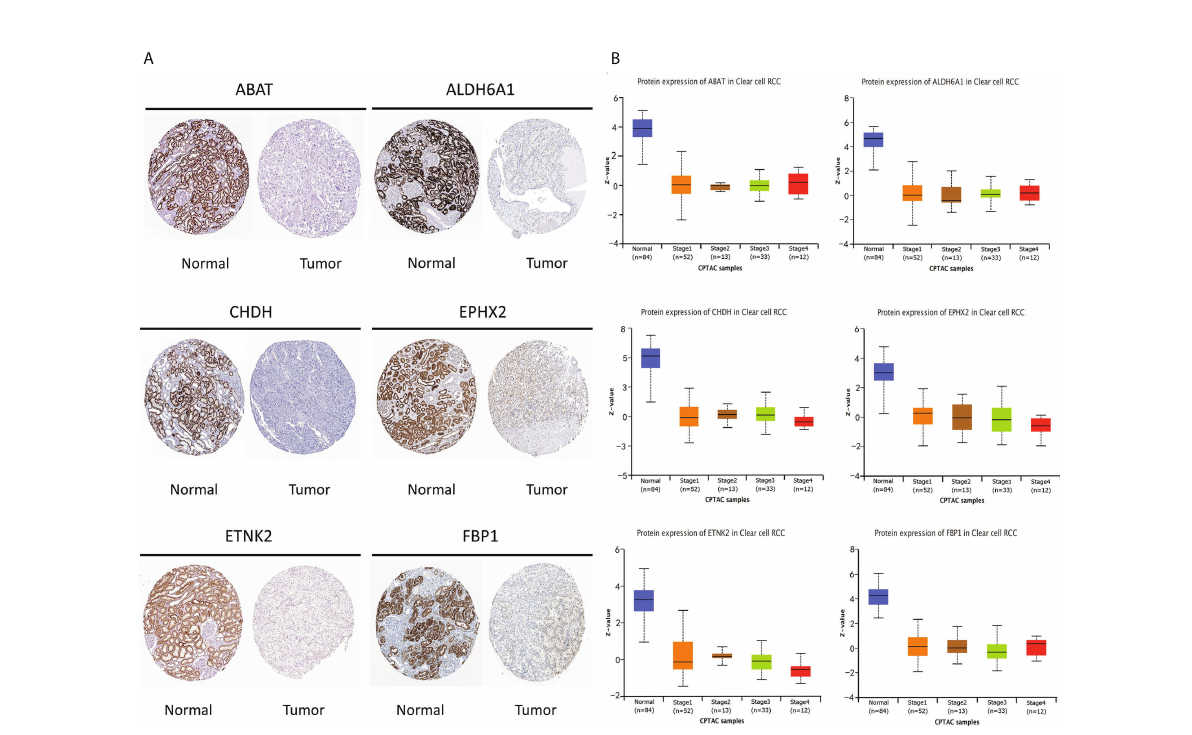
FIGURE 5 The protein level of the six key genes in kidney normal tissues and ccRCC tissues. (A) Immunohistochemical of the six key genes based on The Human Protein Atlas database. (B) The protein expression of the six key genes in normal tissues and different stages of ccRCC tissues based on the Clinical Proteomic Tumor Analysis Consortium